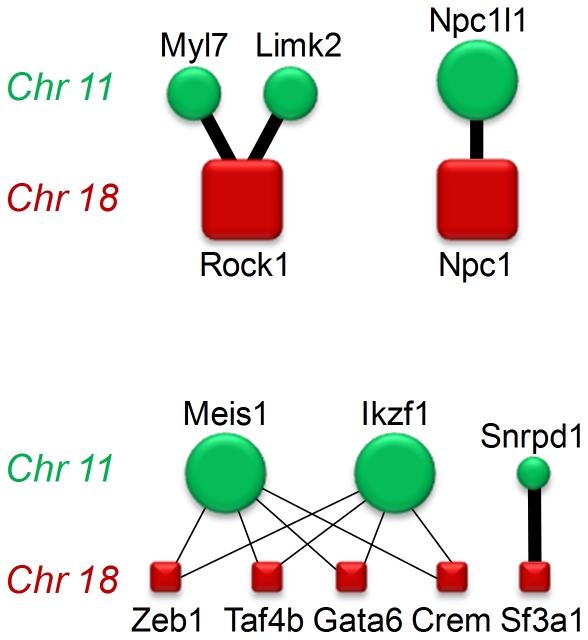
Network prioritization of potential interactions between proteins encoded by genes located within the linked regions on chromosomes 11 and 18.Proteins and their interactions were prioritized using extended SPAN modeling as described in Methods. Among all potential interactions, only two networks (Limk2, Rock1, Myl7; and Npc1, Npc1l1) included prioritization of both proteins (nodes) and their interactions (edges) at a false discovery rate of less than 0.0001. Every protein-protein interaction in which at least one node or one edge was prioritized is displayed. Prioritization is denoted as follows: Large genes and thick interaction lines - false discovery rate (FDR)<0.0001; medium size genes - FDR<0.5; small genes and thin interaction lines - FDR>0.5.